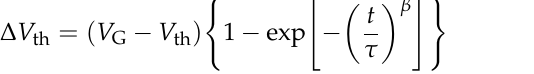
Figure 7. PBS of InTiO TFTs with various Ti 4+ concentrations, ( a ) 18:1, ( b ) 15:1, and ( c ) 10:1. ( d ) The dependence of Δ V th on the stress time of InTiO TFT devices. ( e ) The fitted curves described by Equation (5).